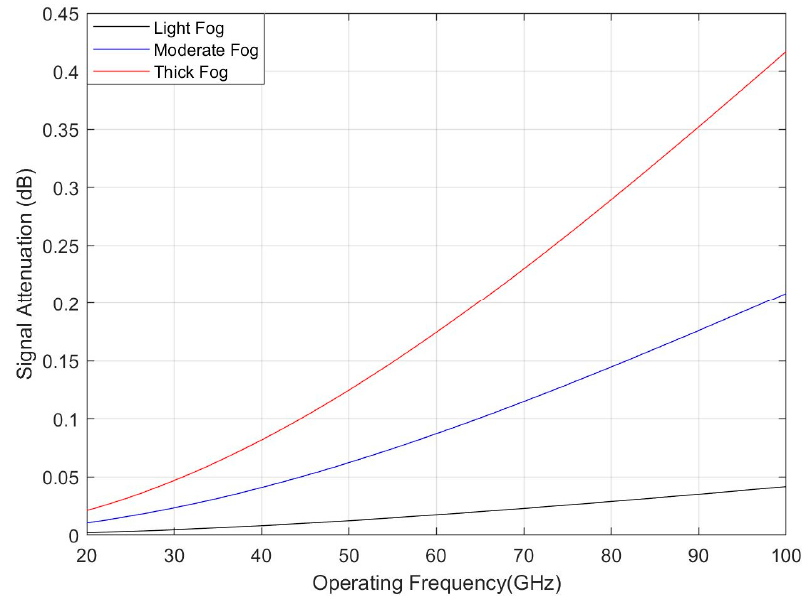
Figure 15. RF signal attenuation due to fog for different operating frequency.